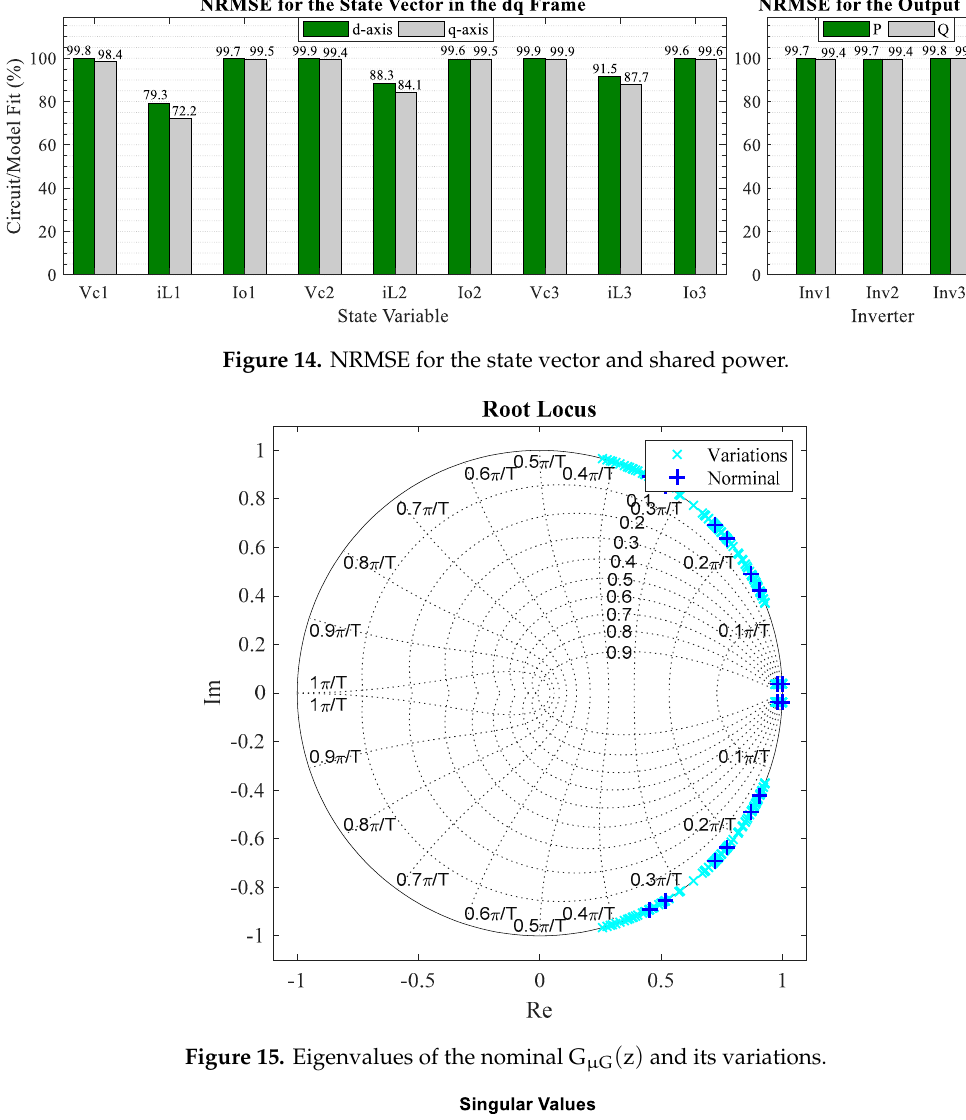
Figure 15. Eigenvalues of the nominal G μG (z) and its variations.